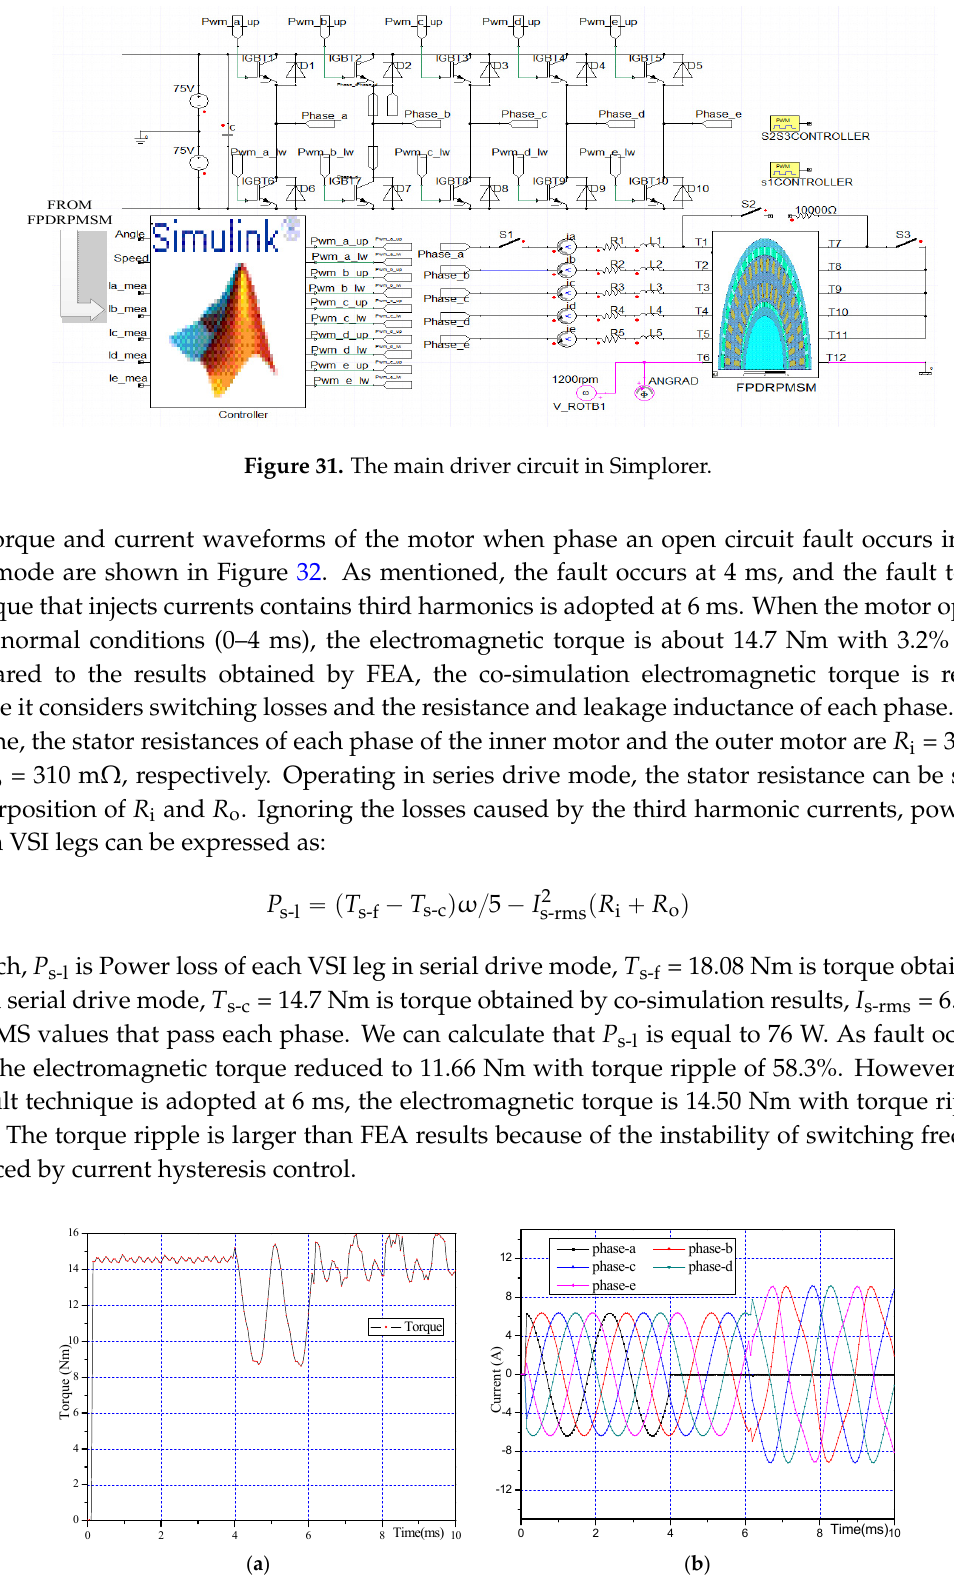
Figure 30. Fault tolerant control structure in Simulink.